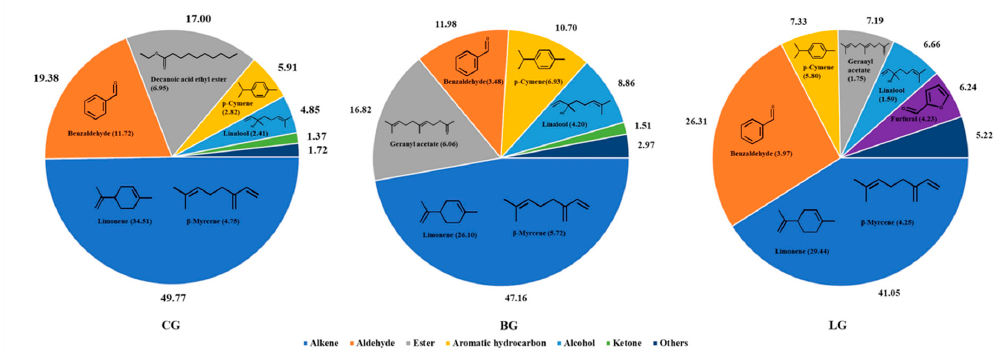
Figure 1. Ratios (%) of volatile compounds in three groups of citrus blend black teas. CG (Citrus group), others: ether (0.94), alkane (0.25), oxyheterocyclic compound (0.22), acid (0.12), nitrogen-containing compound (0.11), phenol (0.08), sulfocompound (0.004); BG (Bergamot group), others: ether (1.25), oxyheterocyclic compound (1.06), phenol (0.25), nitrogen-containing compound (0.20), alkane (0.12), acid (0.07), sulfocompound (0.004), alkyne (0.003); LG (Lemon group), others: ketone (3.05), ether (0.85), acid (0.52), nitrogen-containing compound (0.50), alkane (0.20), phenol (0.10), sulfocompound (0.001), alkyne